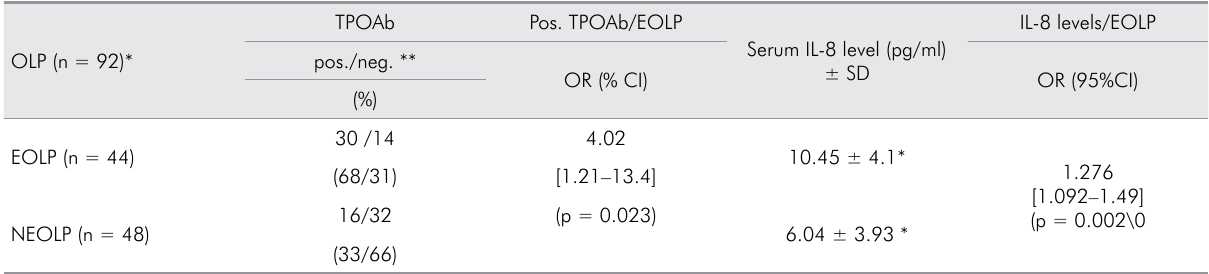
Table 3. Mean levels of serum positive* anti-TPO autoantibodies (TPOAb) and IL-8 (pg/ml) serum levels in patients with EOLP and